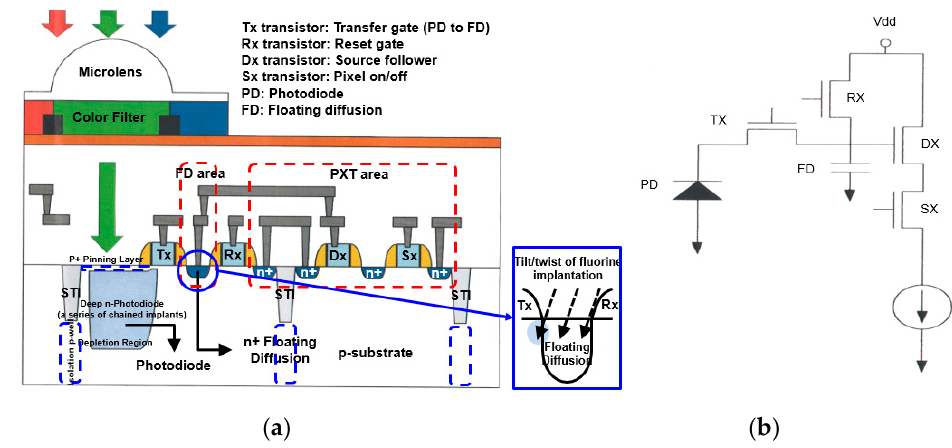
Figure 1. ( a ) Cross-sectional illustration of CMOS image sensor. ( b ) Schematics of 4T pixel